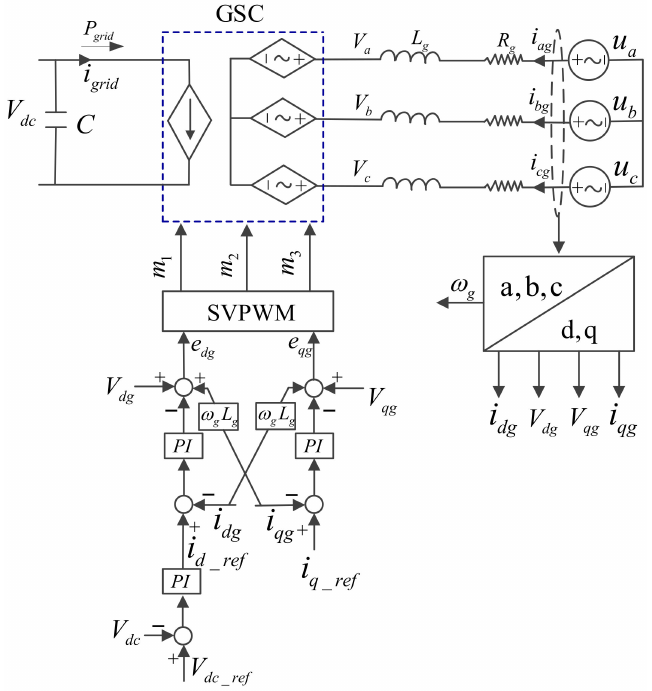
Figure 6. Control structure of the grid-side converter.